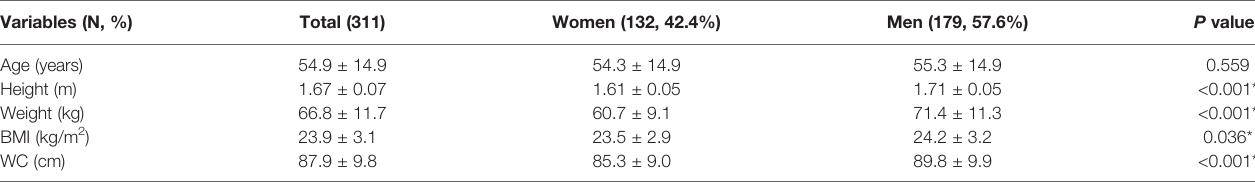
TABLE 2 | Characteristics of the study population.